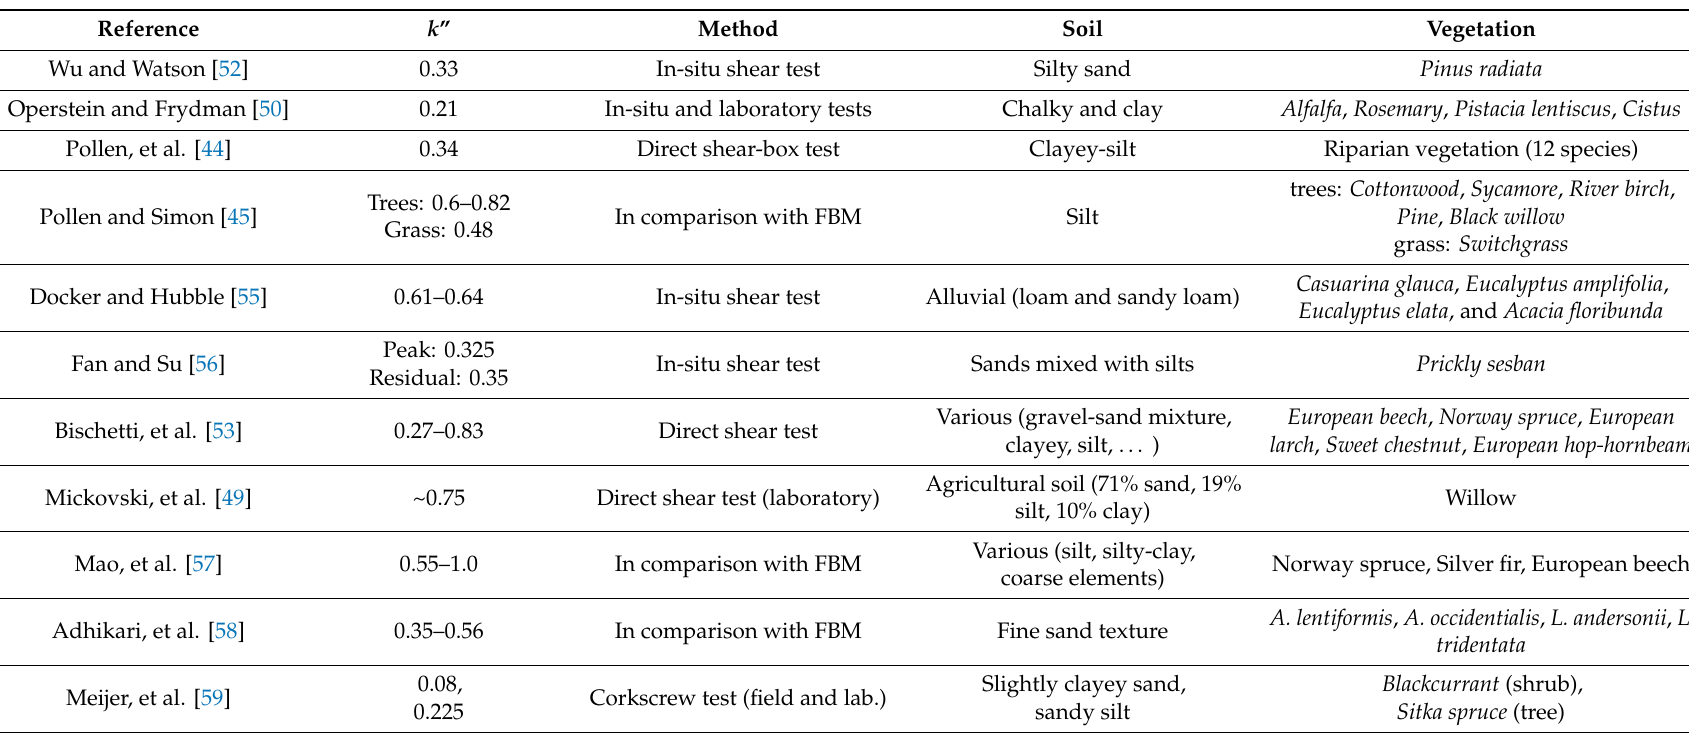
Table 2. The reduction factor reported by some researchers to the modified Wu / Waldron model